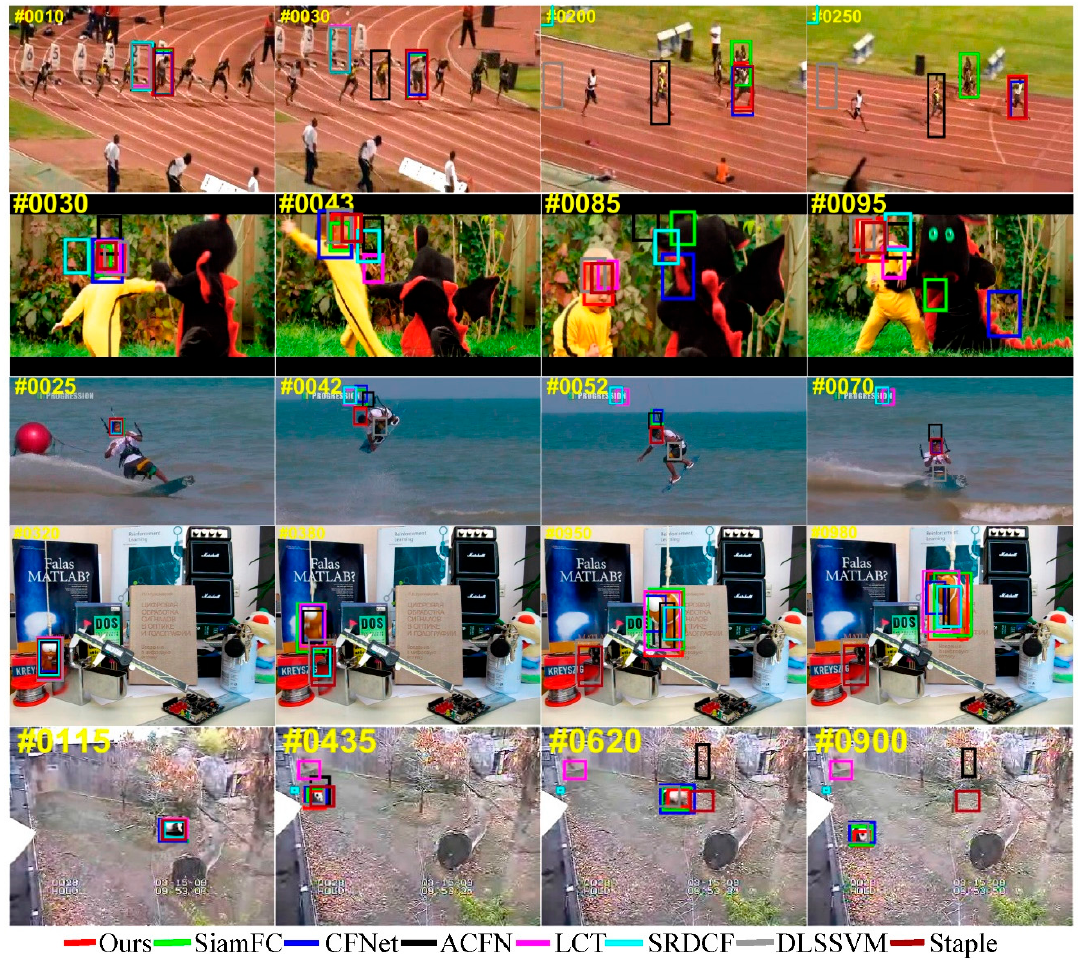
Figure 8. Tracking results on the five sequences of OTB2015 from eight algorithms.